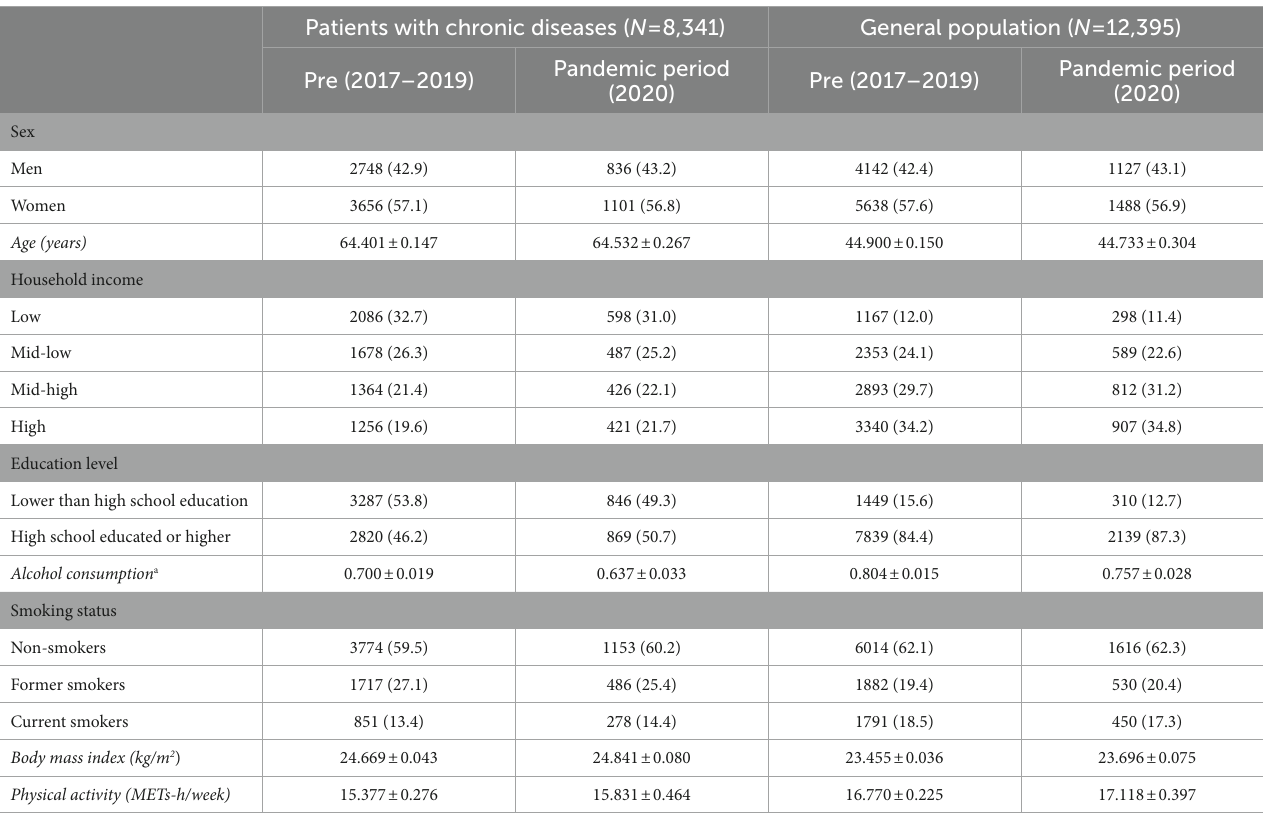
TABLE 1 General characteristics of patients with chronic diseases and the general population across the pre-and the pandemic periods of the COVID-19, KNHANES 2017–2020. Patients with chronic diseases ( N =